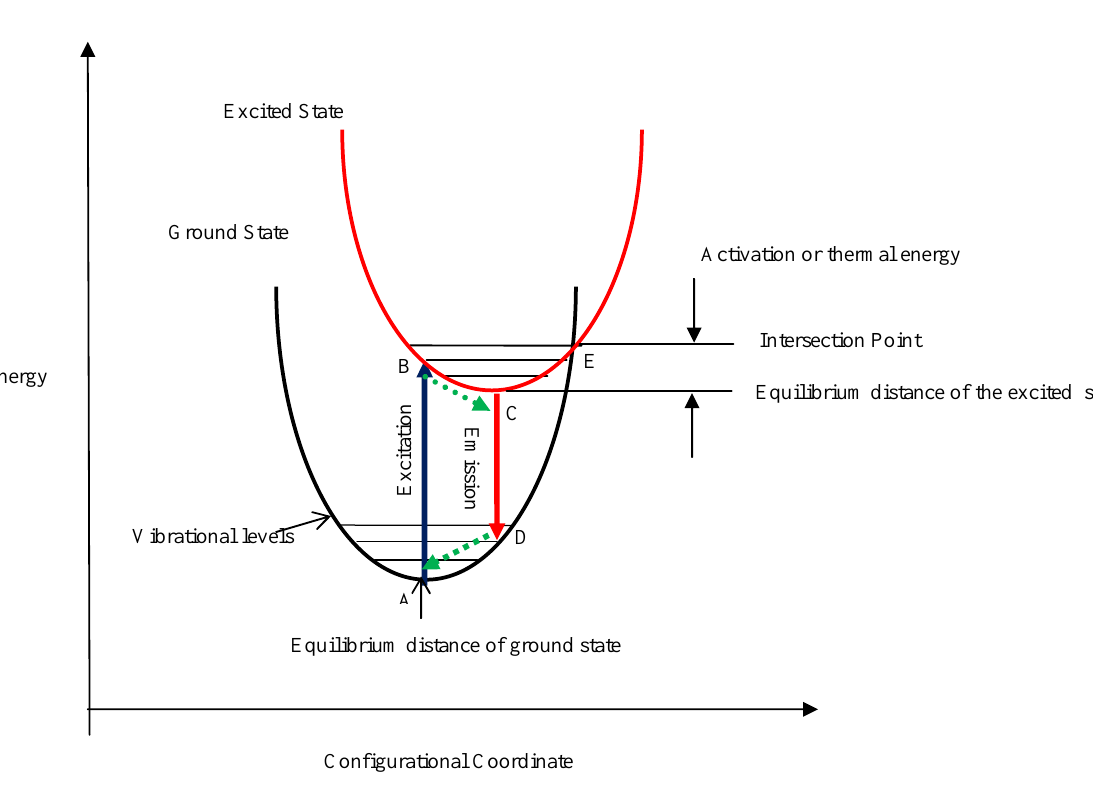
Figure 3. Configuration co-ordinate